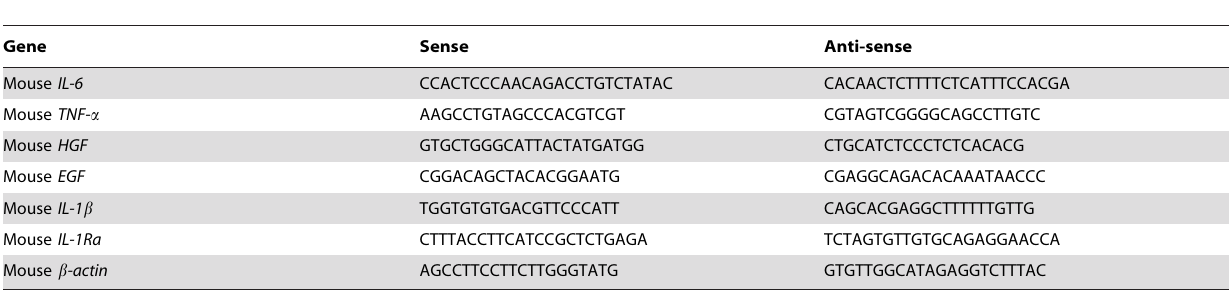
Table 1. Primer sequences used for real-time quantitative PCR.